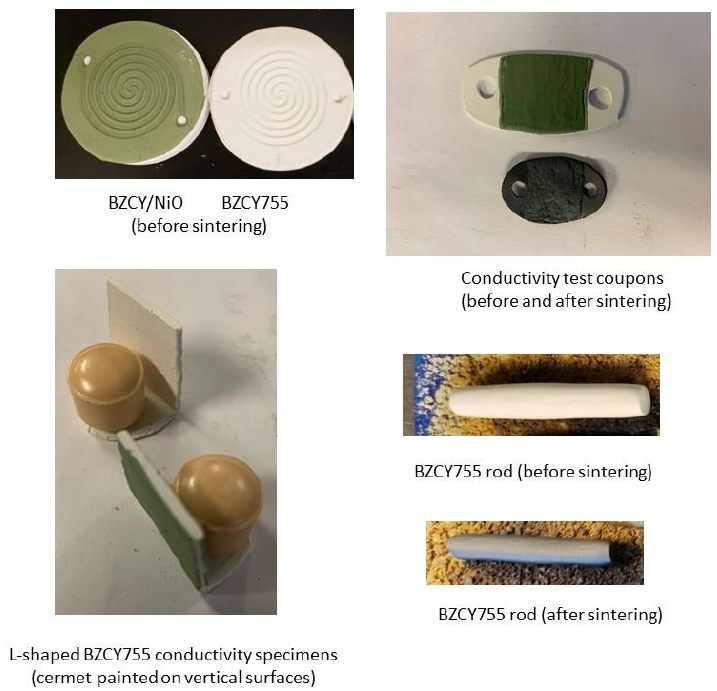
Figure 8. Examples of specimens prepared by the polymer clay process.